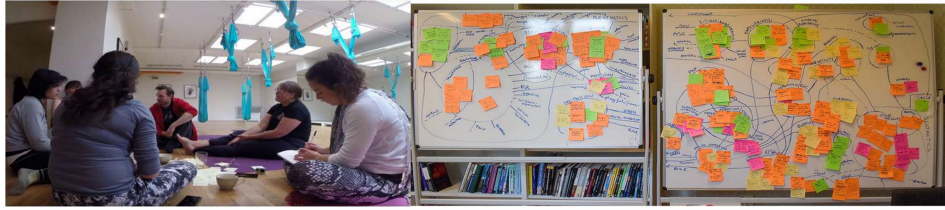
Figure 11. Screenshot from the brainstorming session on the left; picture of the resulting analysis on the right.